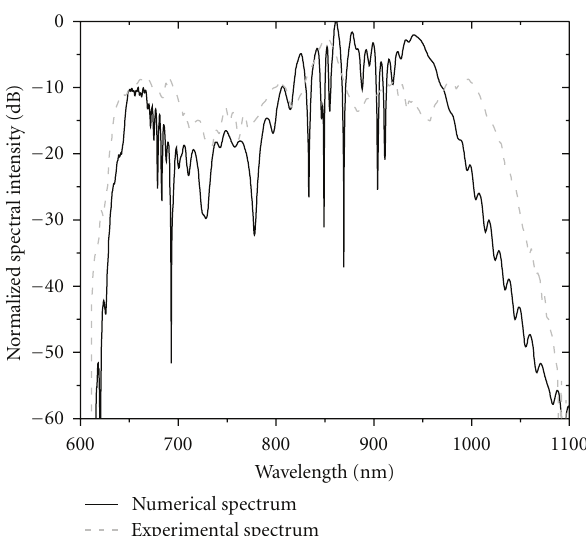
Figure 6: Comparison between numerical and experimental spec- trum of supercontinuum generation.